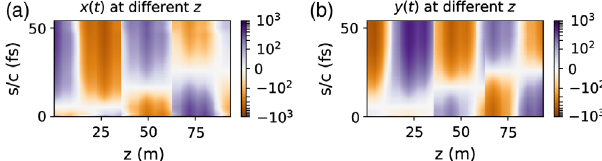
FIG. 7. At different positions z in the undulator beam line, (a) the offset x ð s Þ in X and (b) the offset y ð s Þ in Yalong the bunch in micrometers. The center of the beam line is located at x ¼ y ¼ 0 .